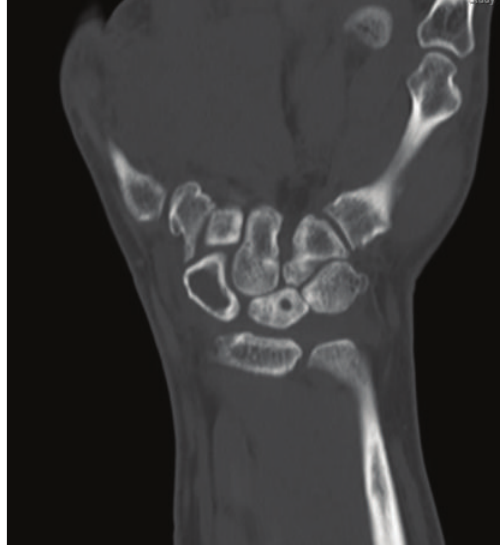
Figure 2: CT: giant interosseous ganglion of the scaphoid and sclerosis of the lunate.